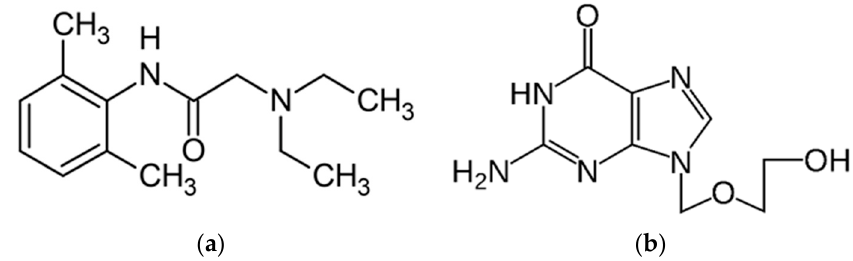
Figure 1. ( a ) Structure of Lidocaine L (SA); ( b ) structure of Aciclovir Av (SA).